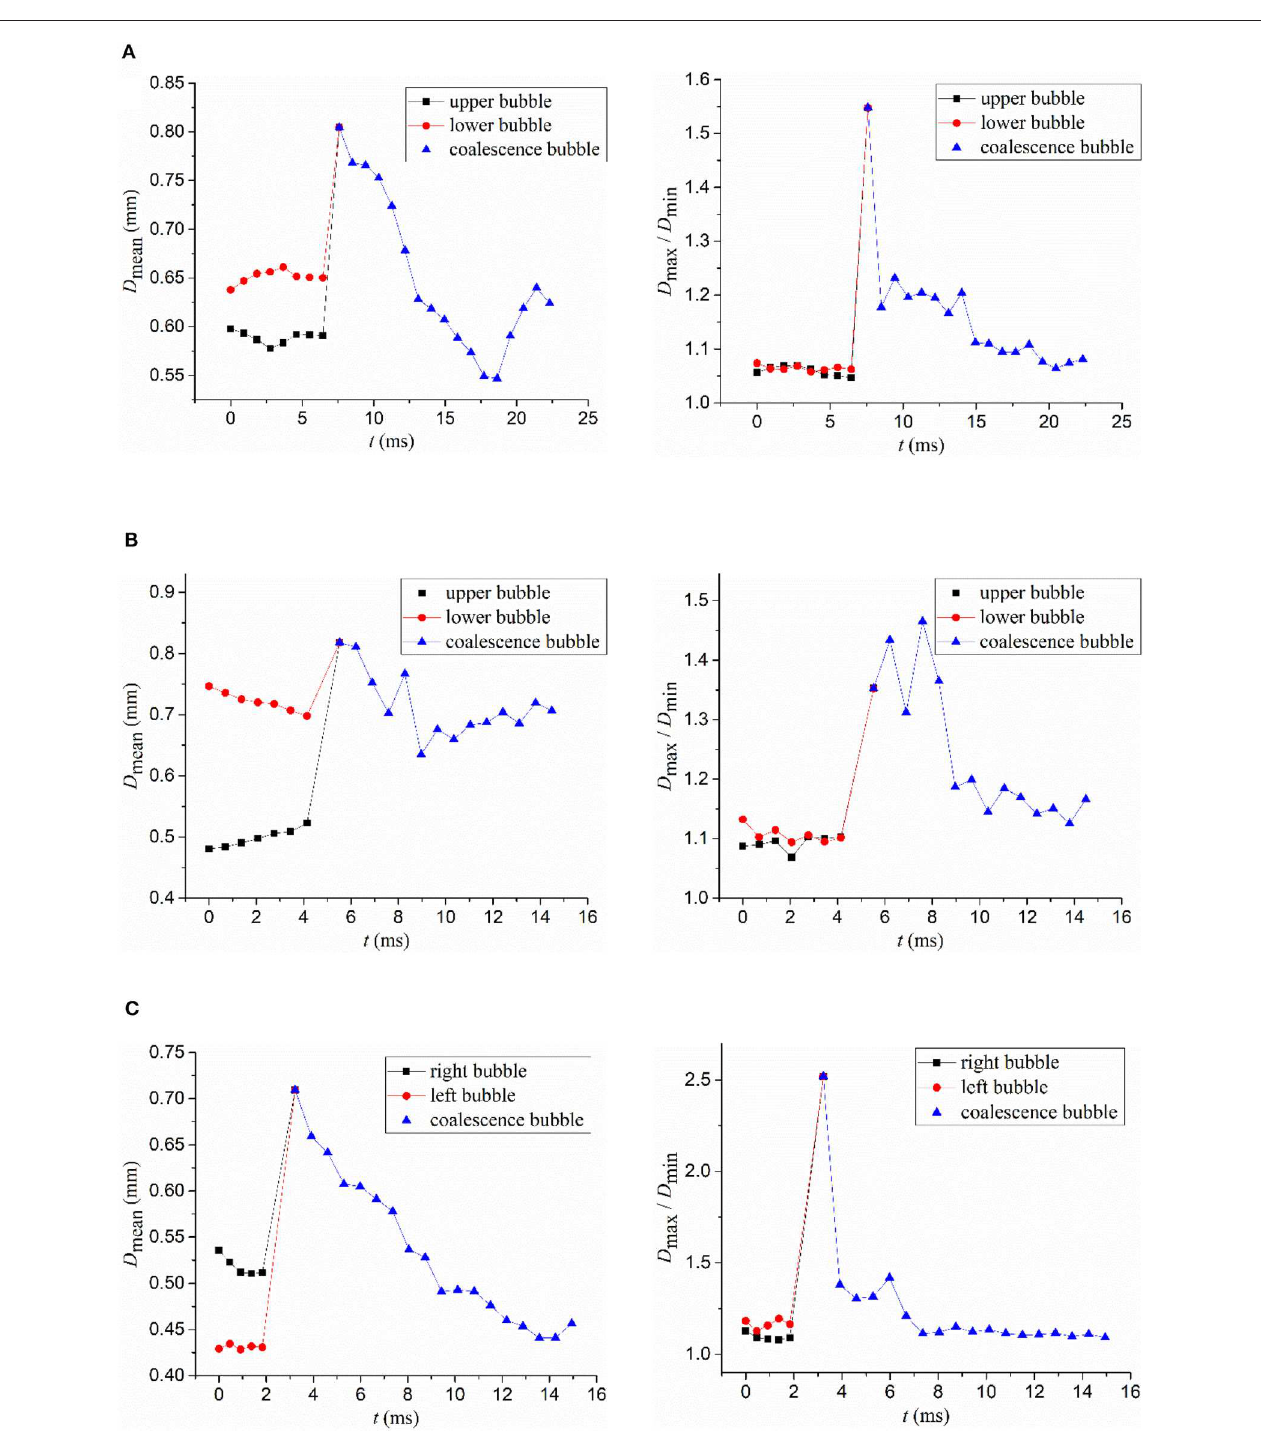
FIGURE 3 | Bubble diameter and shape variation with time. (A) q = 114.3 kW · m − 2 ; 1 T sub,in = 31 ◦ C; G = 333.9 kg · m − 2 · s − 1 , (B) q = 212.2 kW · m − 2 ; = 30.8 ◦ C; G = 619.6 kg · m − 2 · s − 1 , and (C) q = 212.2 kW · m − 2 ; 1 T 1 T sub,in